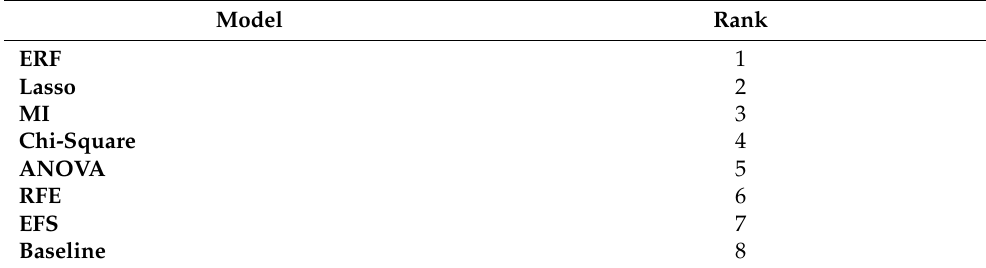
Table 8. Final results of the ARAS rank for feature selection methods.